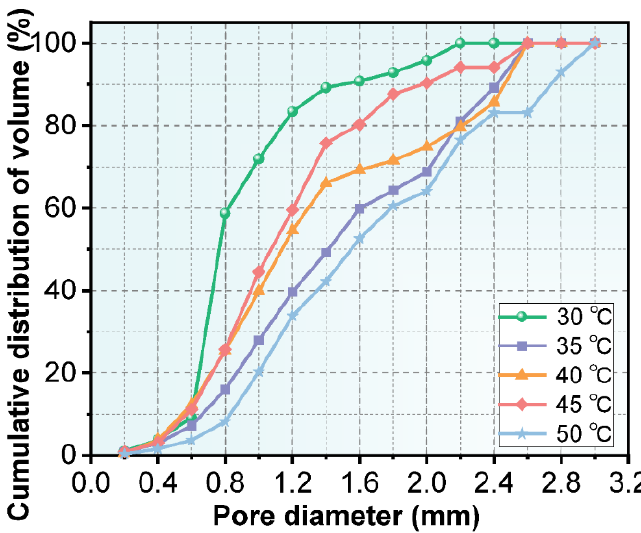
Figure 9. Cumulative frequency distribution of the pore volume at different curing temperatures.